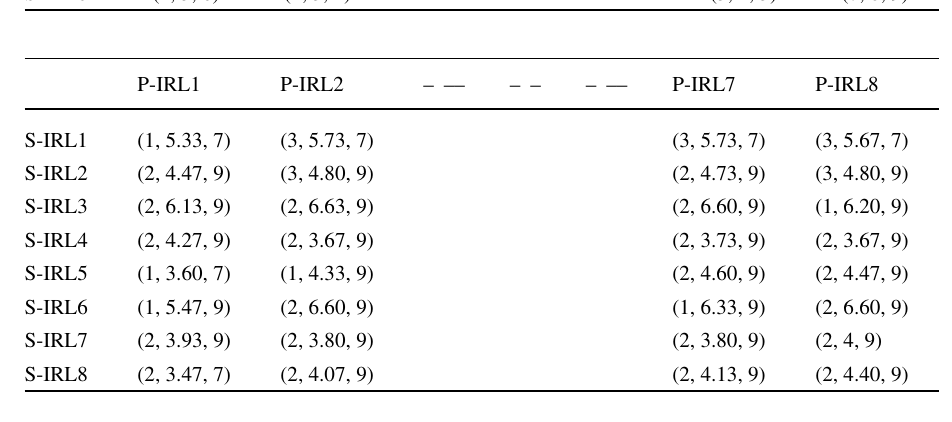
Table 11 Normalized fuzzy evaluation matrix for